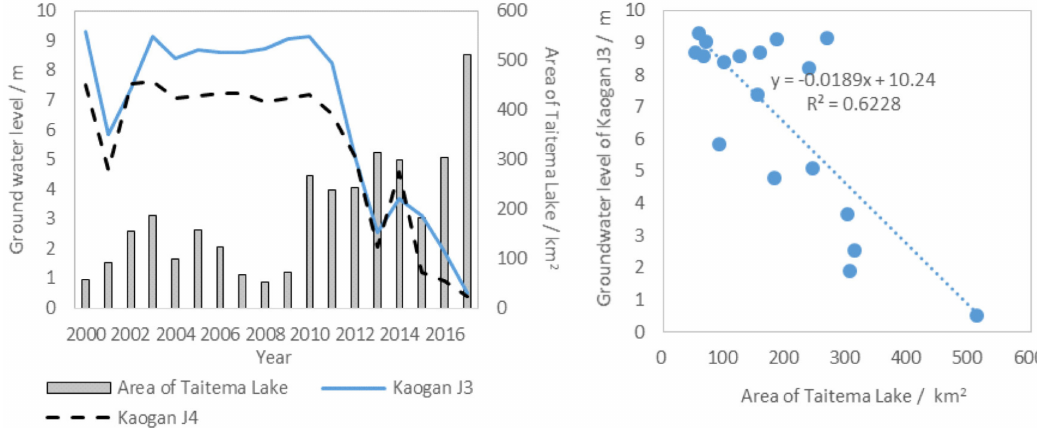
Figure 5. Burial depth of groundwater of Kaogan section from 2000 to 2017 in the terminal lake of Tarim River. With the increase in the lake area, the surrounding groundwater level also rose, but there was a lag phenomenon in the early stage: during the period of 2000 to 2010, there was little change in groundwater level, and it gradually increased as time went on by the end of